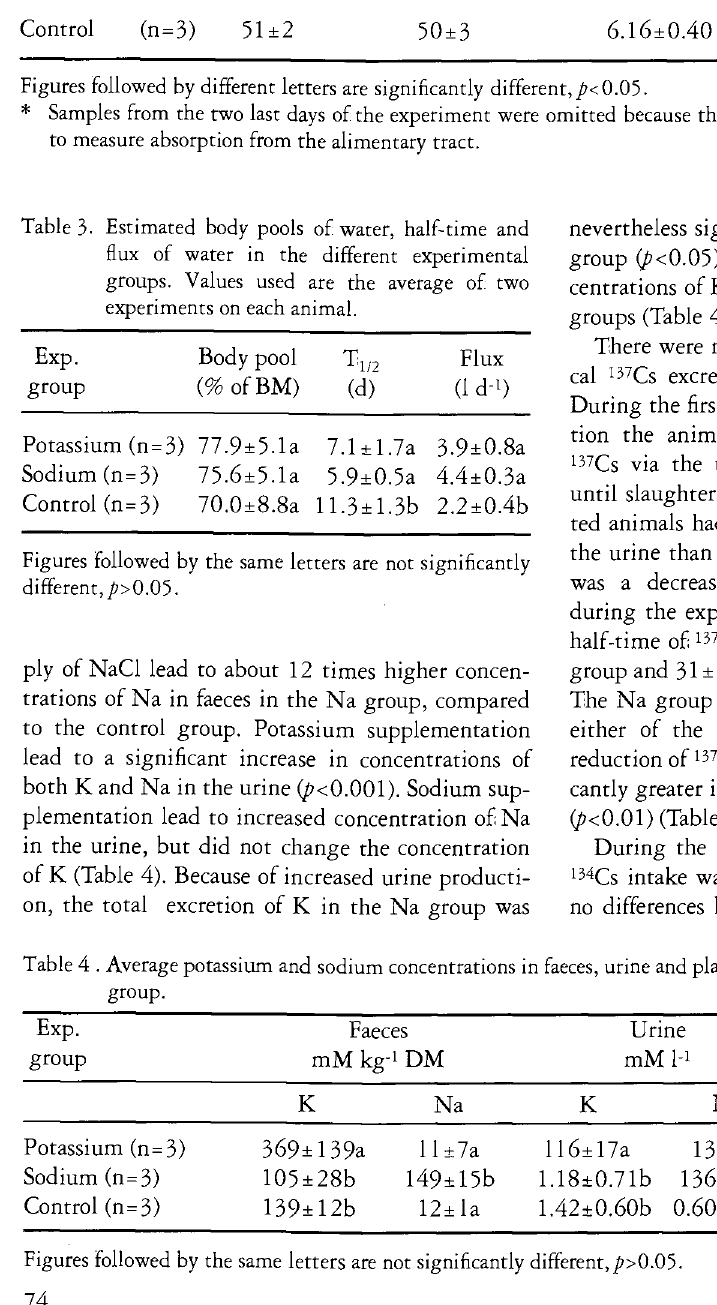
Table 3. Estimated body pools of water, half-time and flux of water in the different experimental groups. Values used are the average of two experiments on each animal.